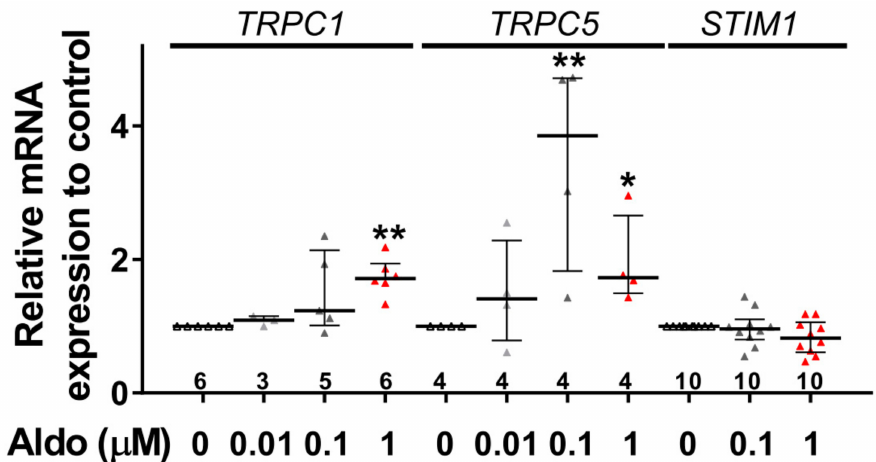
Figure 5. A 24-h aldosterone treatment increases TRPC1 and TRPC5 messenger RNA (mRNA) expression in ARVMs. Relative TRPC1 , TRPC5 , and STIM1 mRNA levels in ARVMs were incubated for 24 h in the absence or in the presence of aldosterone (Aldo 10 nM, 100 nM or 1 µ M). The mRNA levels determined by qRT-PCR were normalized to housekeeping genes and are expressed as fold changes of that determined in ARVMs incubated in the absence of aldosterone for each cell isolation. Results are presented as scatter plots with median and interquartile range. Statistical significance was evaluated using one-way ANOVA (Kruskal–Wallis) followed by post hoc Dunn’s test for multiple comparisons. * p < 0.05, ** p < 0.01 vs.